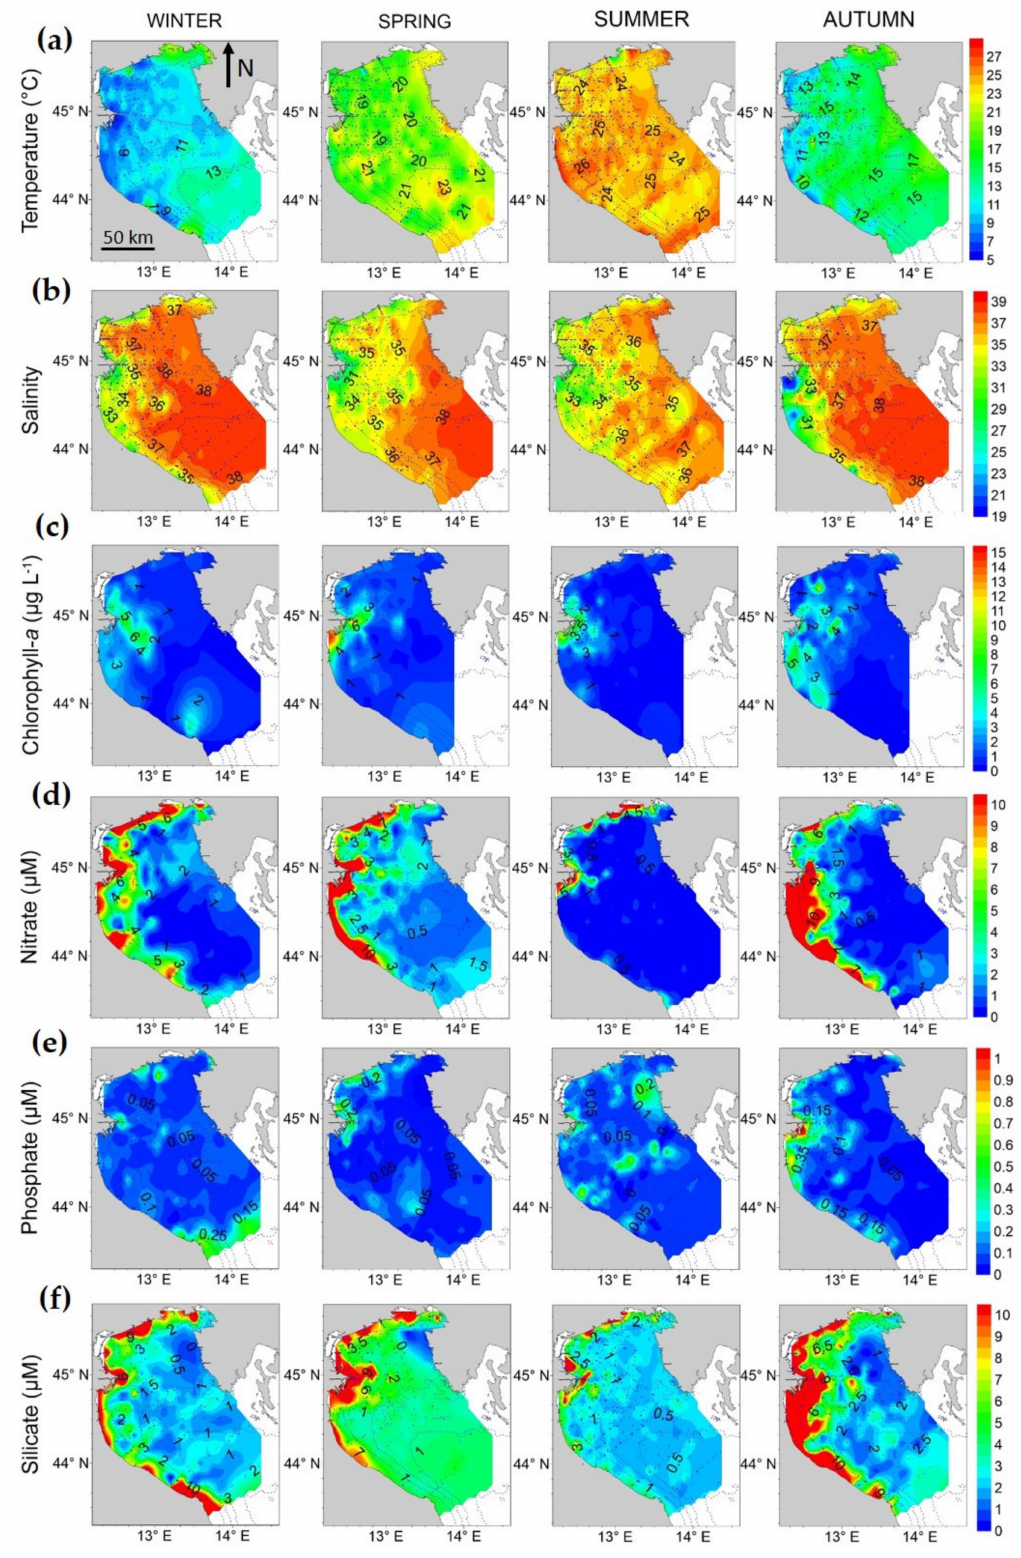
Figure 2. Surface seasonal patterns of ( a ) seawater temperature ( ◦ C), ( b ) salinity, ( c ) chlorophyll- a ( µ g L − 1 ), ( d ) nitrate ( µ M), ( e ) phosphate ( µ M) and ( f ) silicate concentrations ( µ